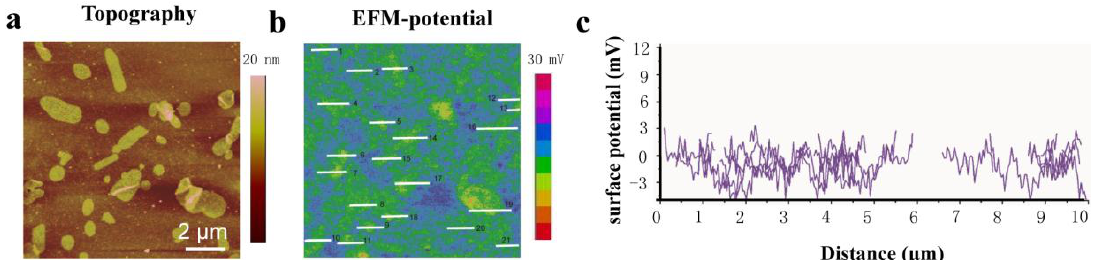
Figure 5. Topography and surface potential of PM on Peptide-3 modified substrates. ( a ) AFM image of PM adsorption on Peptide-3 modified substrates; ( b ) Surface potential image of PM adsorption on Peptide-3 modified substrates; ( c ) Sectional analysis of each patch labeled in EFM potential image. The potentials analysis only gives out one population, ~1 mV, which indicates identical orientation of the PM on